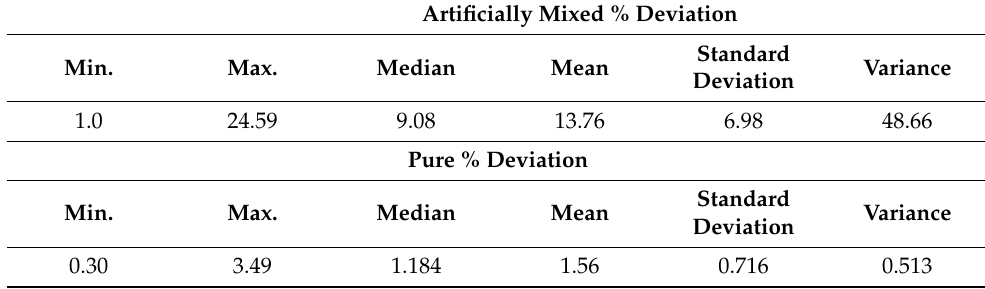
Table 3. Descriptive statistics of artificially mixed and pure